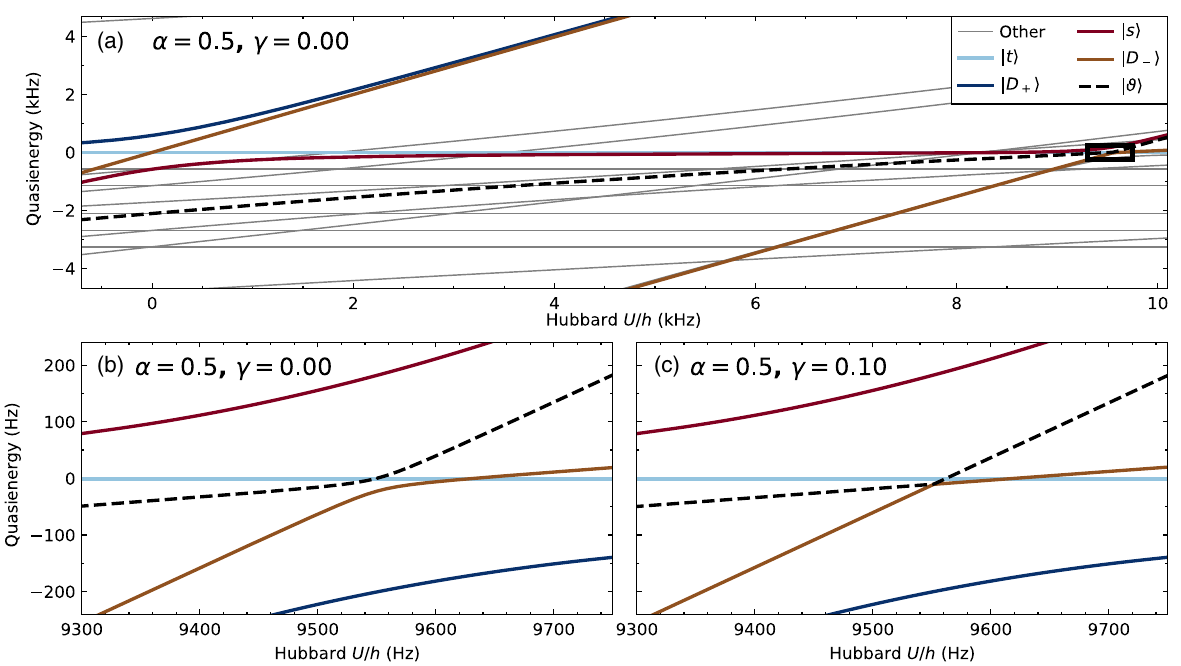
FIG. 6. Quasienergy spectra of the two-site two-band Fermi-Hubbard model (spins ↑ ; ↓ ) with resonant amplitude modulation. All states that solely occupy ground-band orbitals ( h ˆ n e i ¼ 0 ) are denoted by thick colored lines. (a) Full quasienergy spectrum (one Floquet zone) for a single-frequency amplitude modulation of strength α ¼ 0 . 5 and frequency ω = ð 2 π Þ ¼ 9420 Hz. (b) Enlarged spectrum [black box in (a) at 9.5 kHz]. The Floquet drive couples the j s i state (red) to the j D i state (blue), leading to an avoided crossing at roughly þ U ≃ ℏ ω . This resonant effect is accompanied by an additional unwanted avoided crossing of the j D − i ground-band state (light brown) to a state involving both ground- and excited-orbital contributions (black dashed, j ϑ i ). (c) The addition of a second control drive at 2 ω (strength γ ¼ 0 . 10 ) decouples the higher-orbital manifold from the Floquet physics in the ground band by closing the gap between ground- and excited-orbital states. The avoided crossing between j s i and j D i is unaffected by the second þ